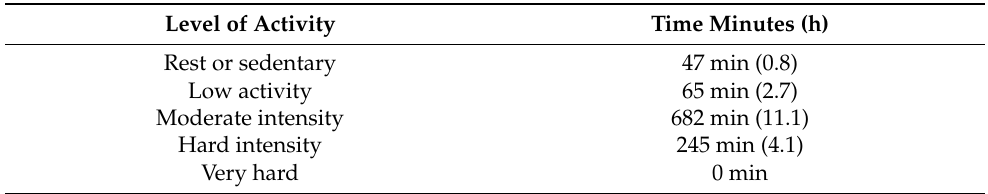
Table 9. Time and physical intensity level during the